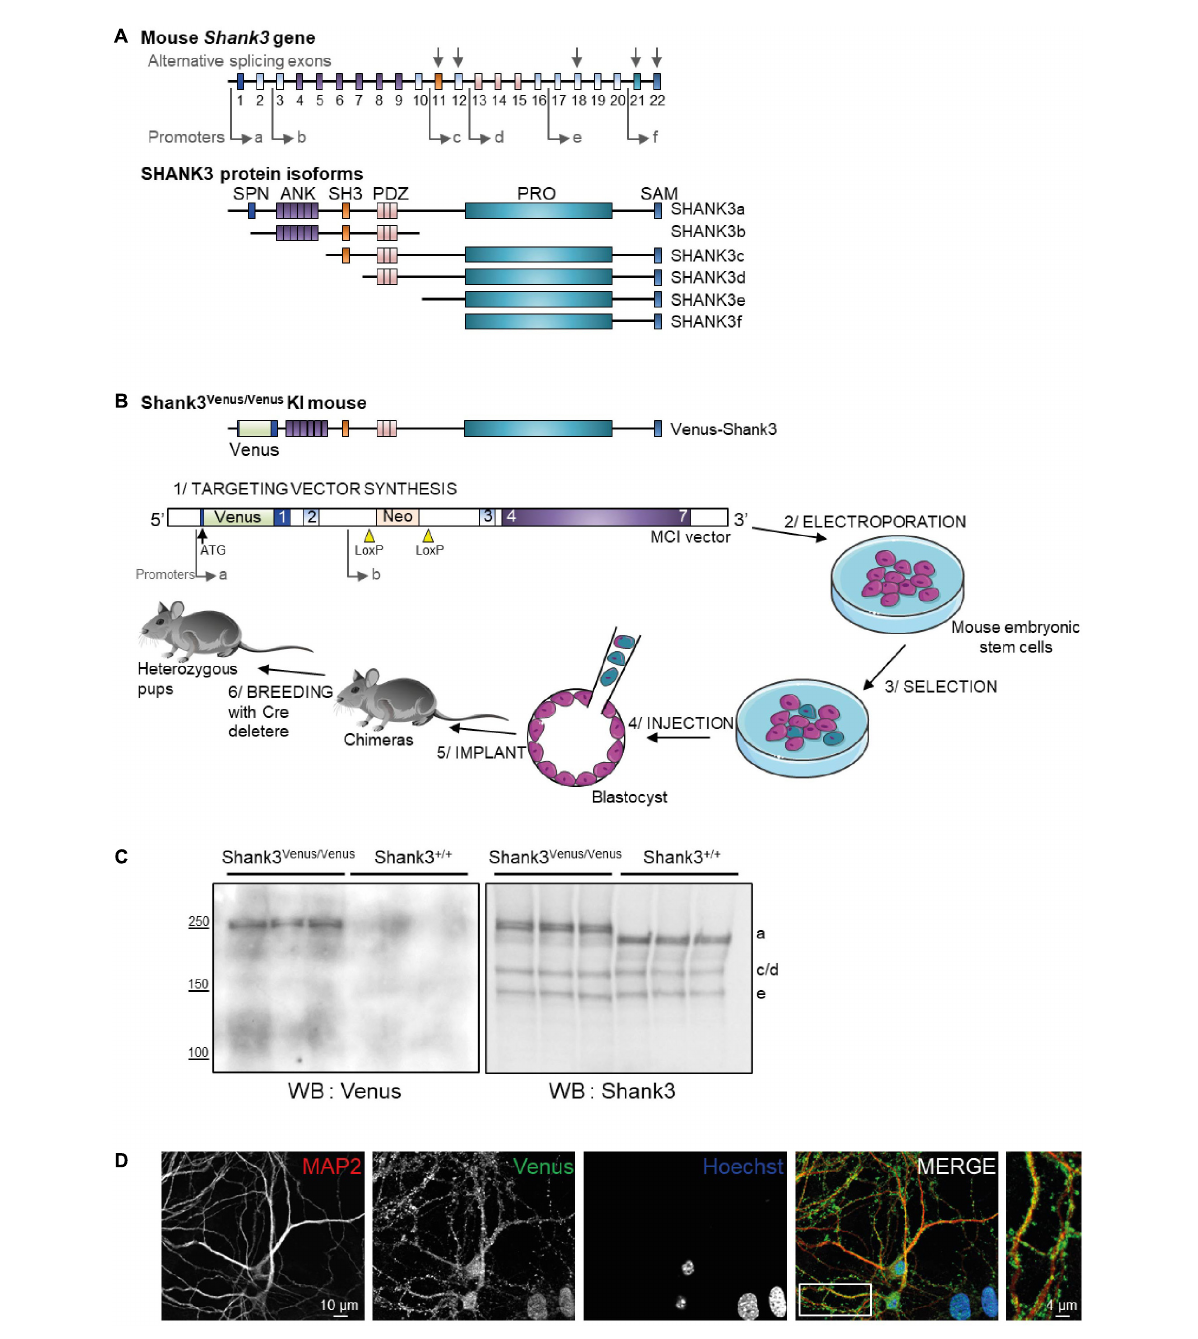
FIGURE1 Generation of the Shank3 Venus / Venus knock in mouse line and detection of Venus Shank3a isoform expression. (A) Schematic representation of the mouse Shank3 gene structure and protein domains of the different protein isoforms. Sites of intragenic promoters and alternative splicing exons are represented by arrows. SPN for Shank3/ProSAP N-terminal domain (1-75 aa); ANK for Ankyrin repeat domain (148-345 aa); SH3 for src Homology-3 domain (470-529 aa); PDZ for PSD-95/DLG/ZO-1 domain (570-664 aa); PRO for proline-rich domain (831-1417 aa); SAM (1667-1730 aa). (B) Schematic representation of the Venus-Shank3 protein domains and steps of Shank3 Venus / Venus KI mouse line creation. Please note that the Venus coding sequence was inserted at the beginning of exon 1 (in frame with and just after the ATG), enabling the exclusive Venus-tagging of the Shank3 variants that are generated by the first promoter, Shank3a isoforms. (C) Total brain lysates from 3 different Shank3 Venus / Venus and Shank3 + / + adult mice were immunoblotted for Venus (left) and Shank3 (right) expressions. Expected molecular weight for untagged Shank3a, 3c/d and 3e isoforms are indicated on the right side of the blot (a, c/d, and e). (D) Immunocytochemistry images from Day In Vitro 15 Shank3 Venus / Venus hippocampal primary cultures stained with antibodies against the dendritic marker MAP2 (red), Venus (green), and the nuclear marker Hoechst